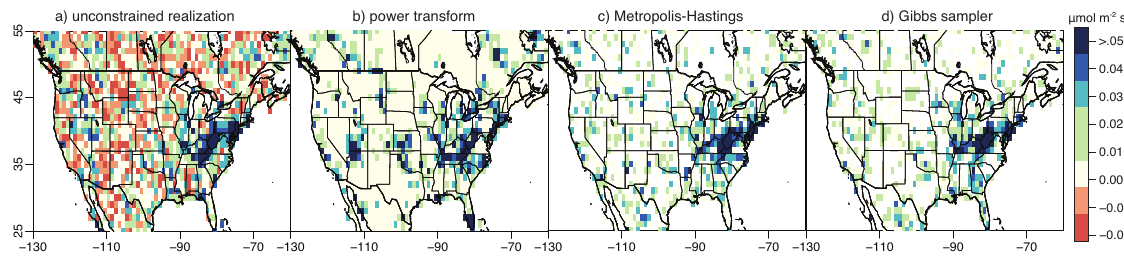
Fig. 5. Example conditional realizations from each different optimization approach.